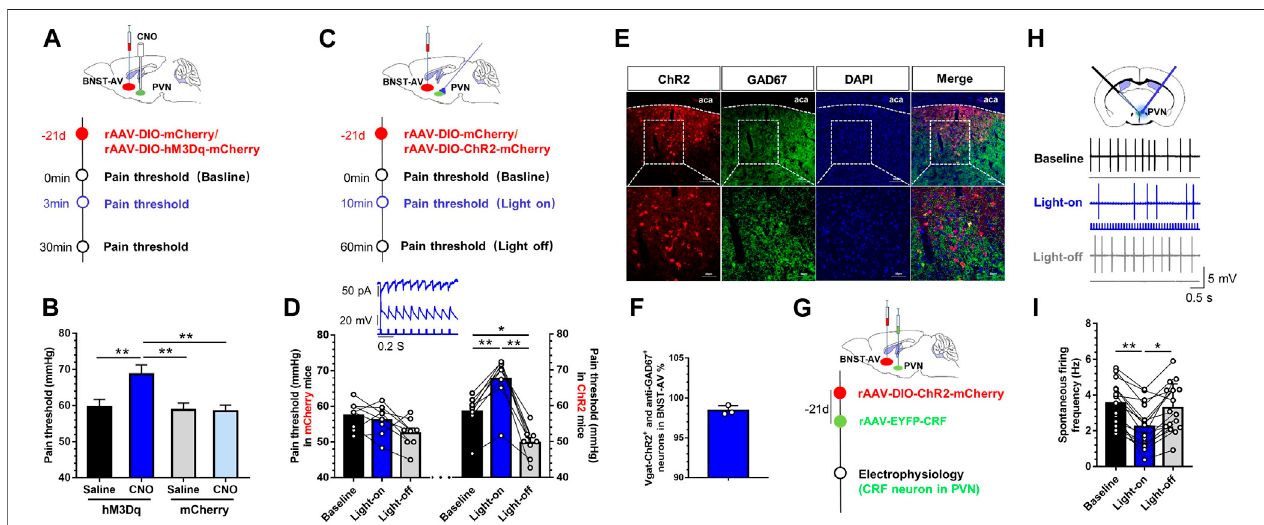
FIGURE 6 | Activation of GABAergic BNST AV -PVN neurons alleviated the visceral pain in mice experiencing MS (A) Schema for injection of AAV-DIO-hM3Dq- mCherry into the BNST-AV for rescue of inhibitory neurons in Vgat-Cre mice experiencing MS (B) The visceral pain threshold signi fi cantly increased post-CNO PVN- injection( n (cid:2) 6,** p < 0.01) (C) SchematicdiagramofAAV-DIO-ChR2-mCherryinjectionintotheBNST-AVand fi ber-opticincannulationintothePVNofVgat-Cremice (D) Thevisceralpainthresholdwassigni fi cantlyincreasedafterphotoactivationoftheterminalofPVN-projectingChR2-mCherry-positive neuronsfromBNST-AVarea ( n (cid:2) 6, ** p < 0.01), and optogenetic stimulation to GABA neurons in BNST-AV region led to laser-dependent hyperpolarization current (473nm laser, wave width: 10ms, frequency: 10Hz) (E) The Vgat-ChR2-mCherry neurons were stained with antibody to GAD67 to verify effects of virus-labeled GABAergic neurons in the BNST-AV (F) The co-standard rate of labeled GABAergic neurons and anti-GAD67 protein was 98.4% (G) In vitro electrophysiological recordings were conducted in ChR2-injected mice (H) The schema of spontaneous fi ring frequency in CRF neurons of PVN (I) Photoactivation of the terminal of PVN-projecting eNpHR-mCherry-positive neurons from BNST-AV area decreased the fi ring rate of CRF neurons in PVN from brain slice from MS mice ( n (cid:2) 18, six mice per group; ** p < 0.01).